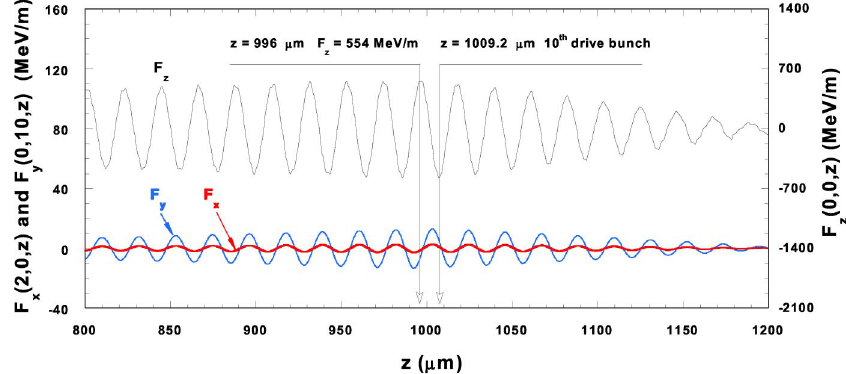
(cid:5) 2 (cid:4) m ; 0 ; z (cid:7) , F (cid:5) 0 ; 10 (cid:4) m ; z (cid:7) , and F (cid:5) 0 ; 0 ; z (cid:7) on axial distance z , excited by ten x y z